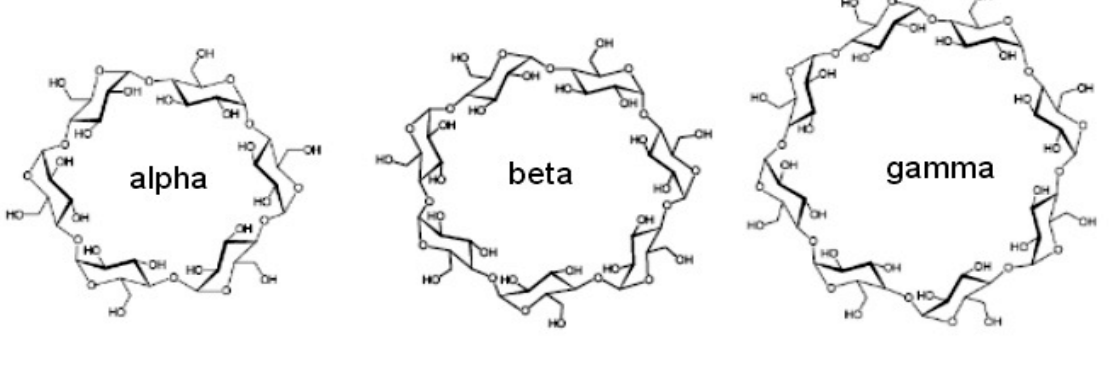
FIGURE 3. Truncated cone shape of a gamma cyclodextrin showing location of hydroxyl groups along rims.